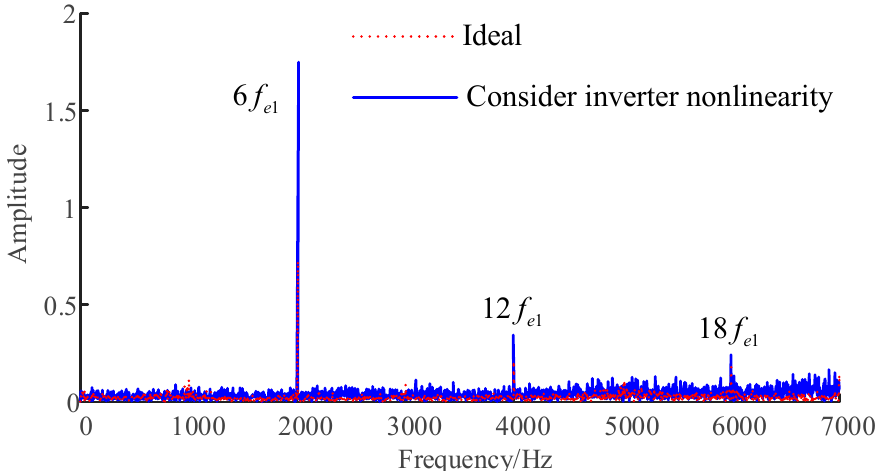
Figure 3. Frequency domain of PMSM electromagnetic torque.